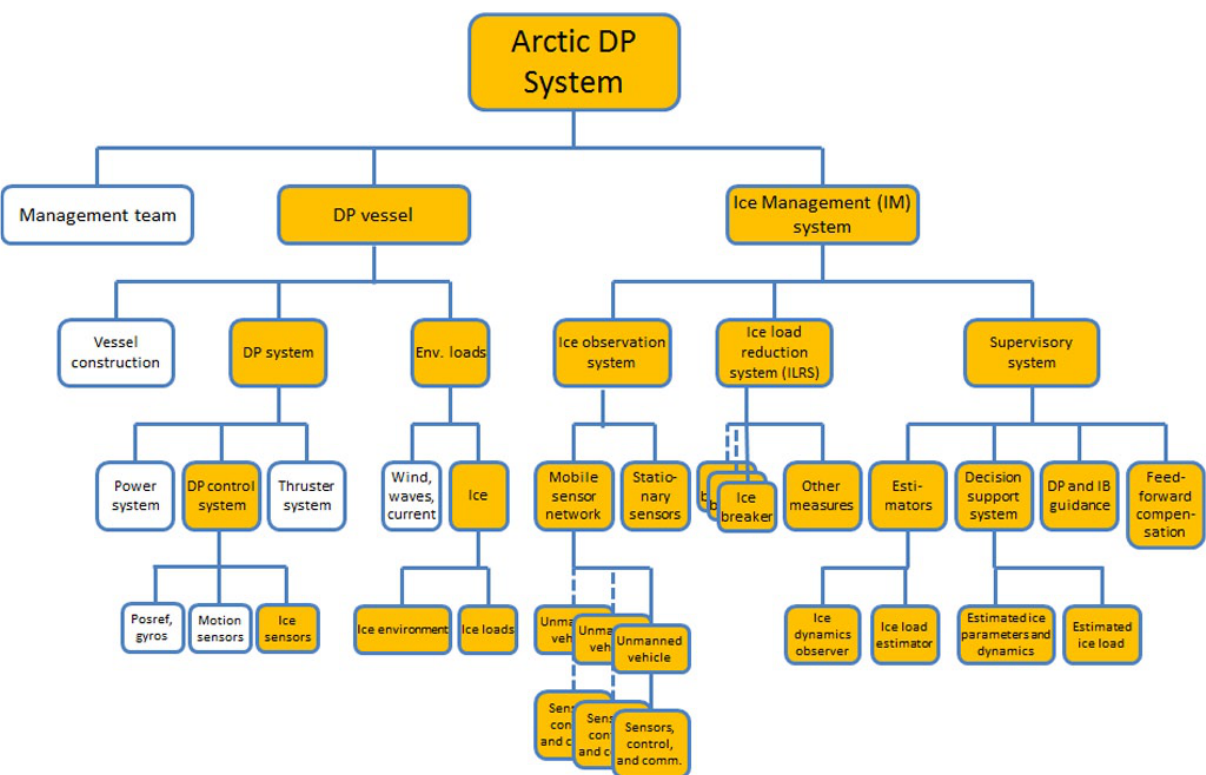
Figure 3: Arctic DP work breakdown